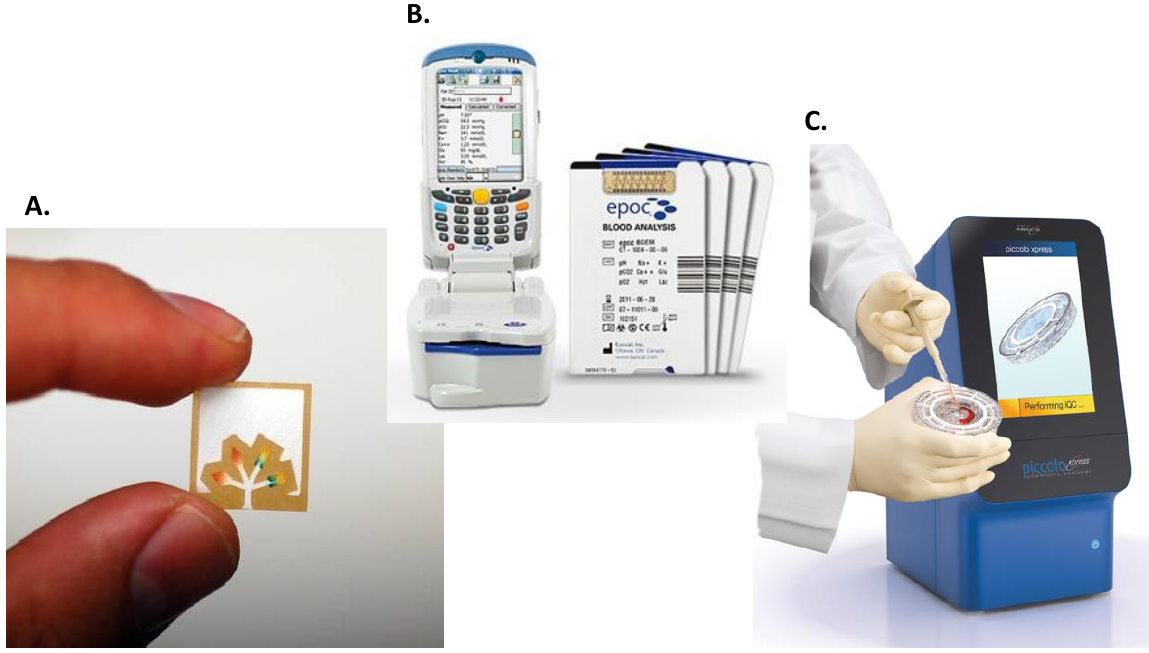
Figure 3. Examples of microfluidic-based platforms. ( A ) Paper-based microfluidic device for simultaneous quantification of glucose and other analyte in urine. Taken from http://gmwgroup.harvard.edu with permission from Prof. Whitesides; ( B ) Lab-on-a-chip platform developed by Alere for blood chemistry analysis. Reproduced with permission from Alere; ( C ) Lab-on-a-disc diagnostic device designed by Abaxis. Reproduced with permission from